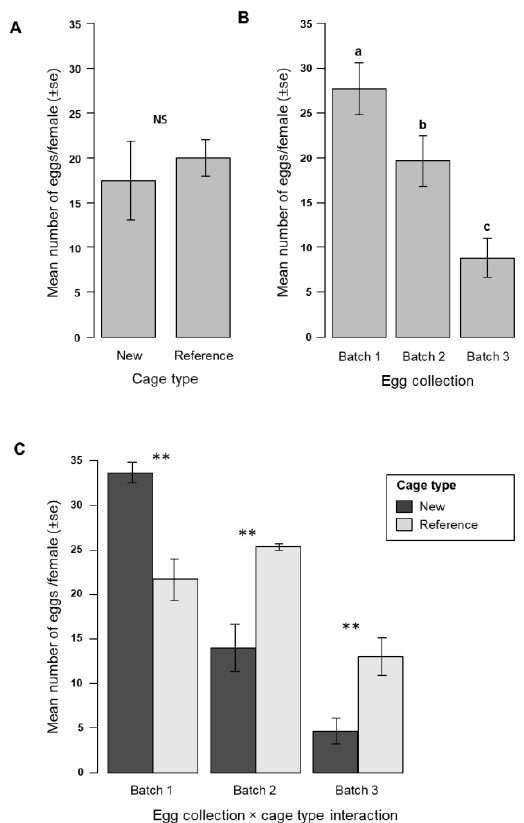
Figure 4. Anopheles arabiensis egg production. Mean number of eggs per female Anopheles arabiensis according to the ( A ) cage type (New, Reference), ( B ) collected egg batch, and ( C ) interaction between cage type and egg batch. Different letters above the bars indicate significant differences (post hoc Tukey test, df = 2, p < 0.05). ** indicates a significant difference ( p < 0.01, interaction analyzed with Tukey test). NS stands for nonsignificant difference.